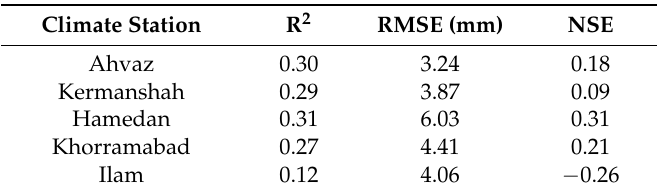
Table 6. Coefficient of determination (R 2 ), root-mean-square error (RMSE) and Nash–Sutcliffe efficiency (NSE) for PERSIANN–CDR during the period from January 2003 to September 2006.